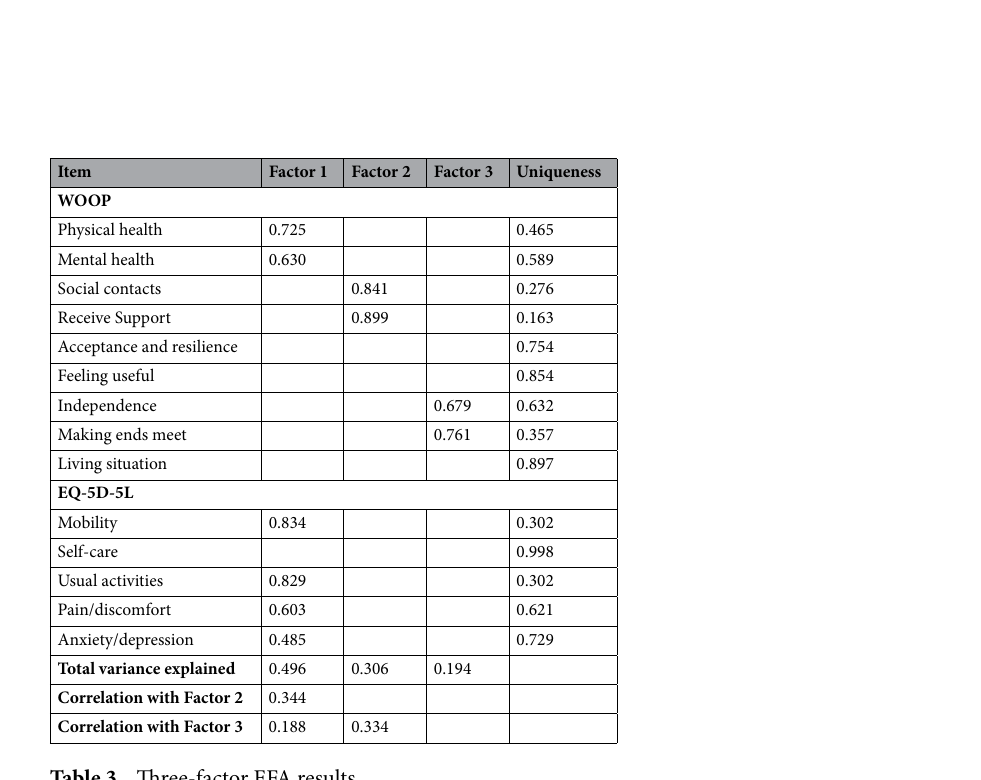
Table 3. Three-factor EFA